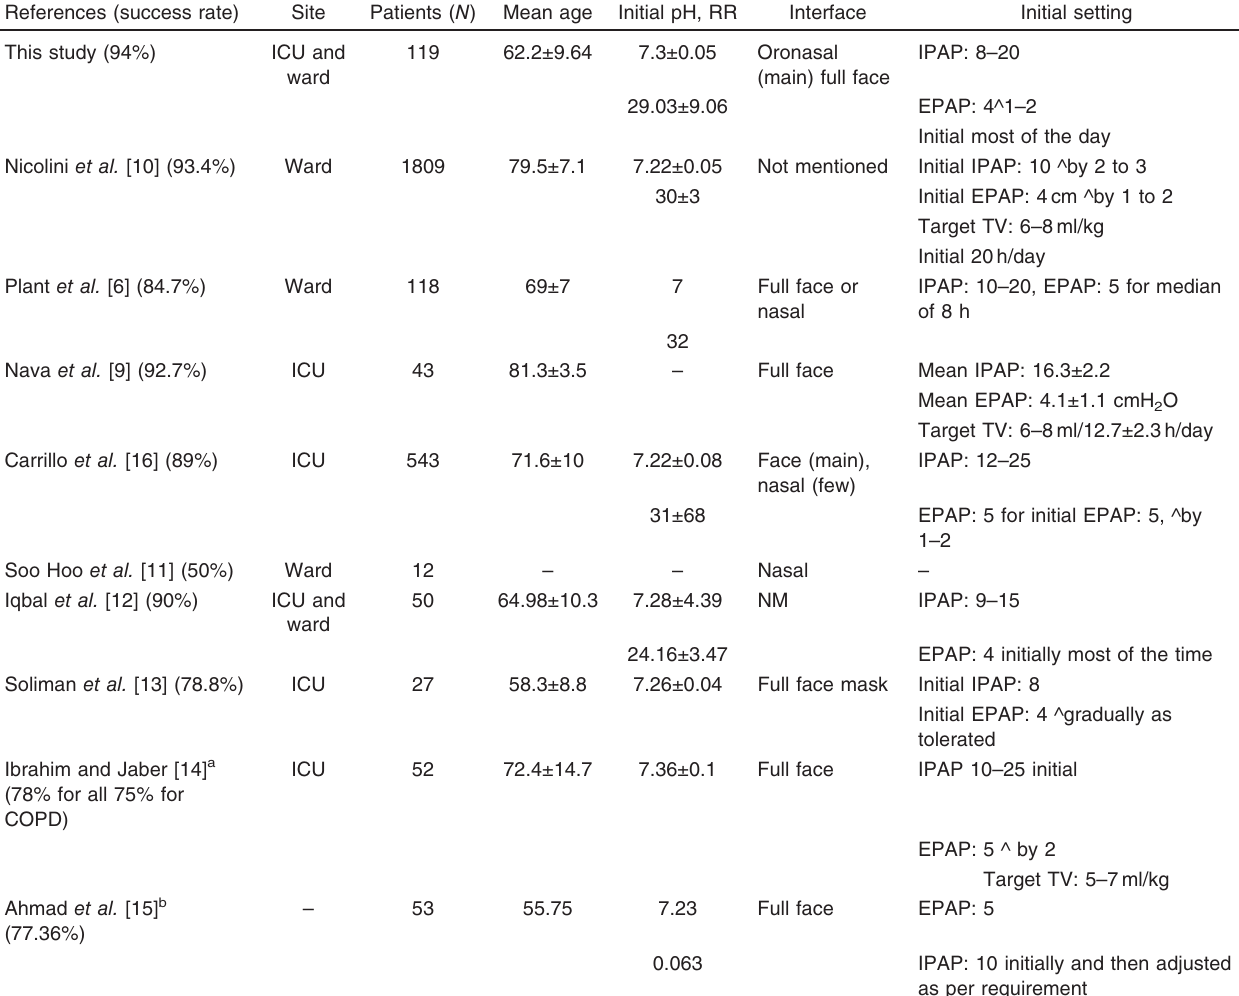
Table 10 Comparison of studies on the use of noninvasive positive-pressure ventilation in acute hypercapnia respiratory failure due to acute exacerbation of chronic obstructive pulmonary disease References (success